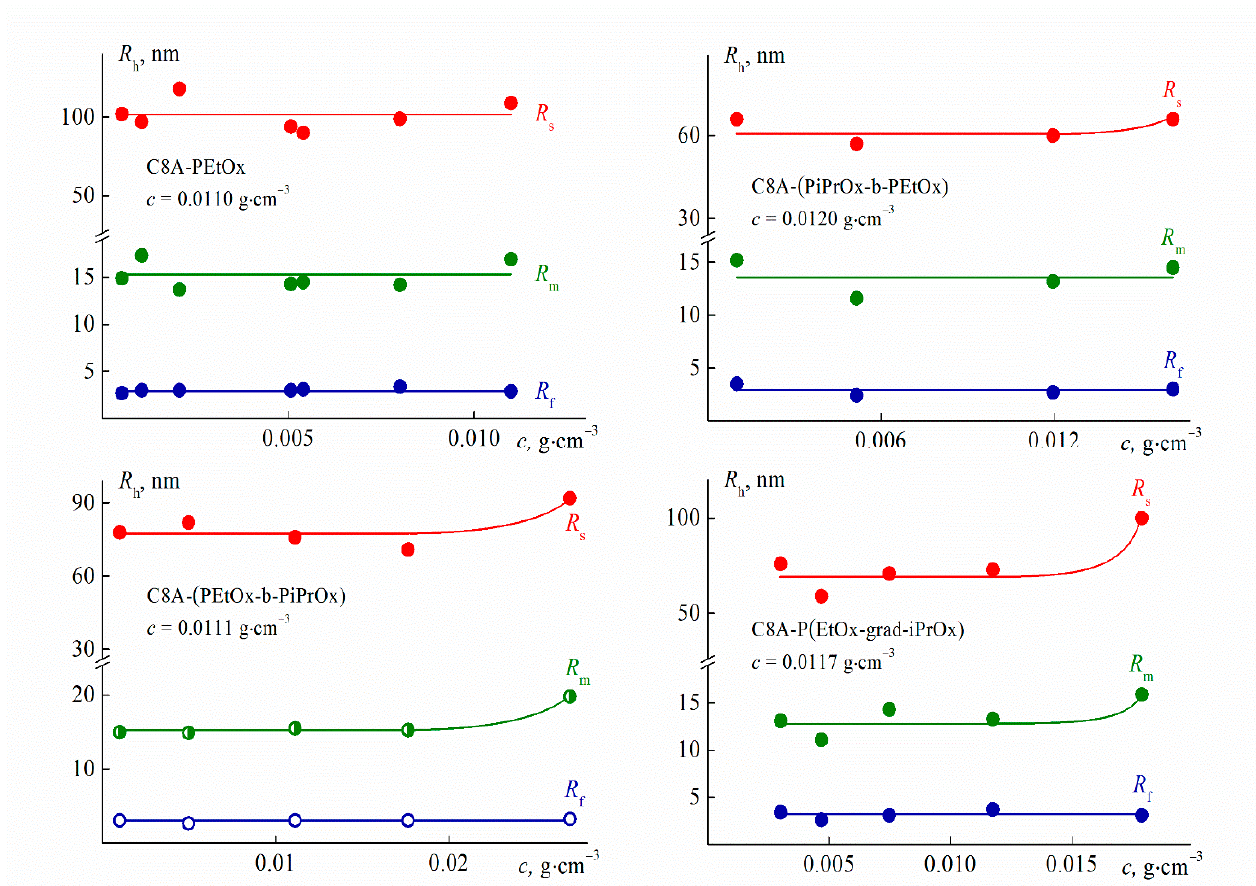
Figure 8. Concentration dependences of hydrodynamic radii R h of scattering species for aqueous solutions of C8A-PAlOx at 21 °C.